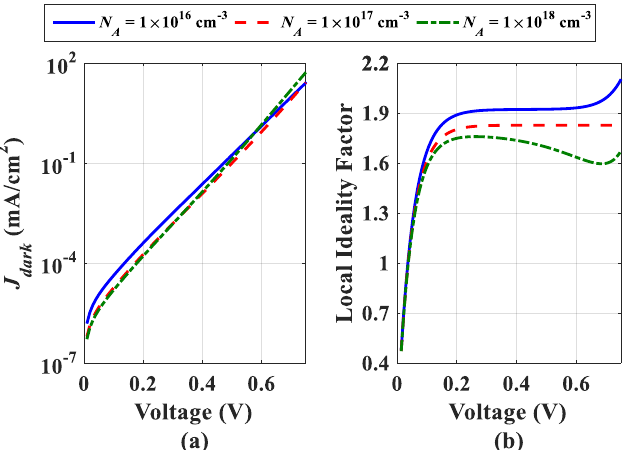
Figure 10. Impact of p-side acceptor concentration. ( a ) The cell dark J–V characteristics, ( b ) the cell local ideality factor.